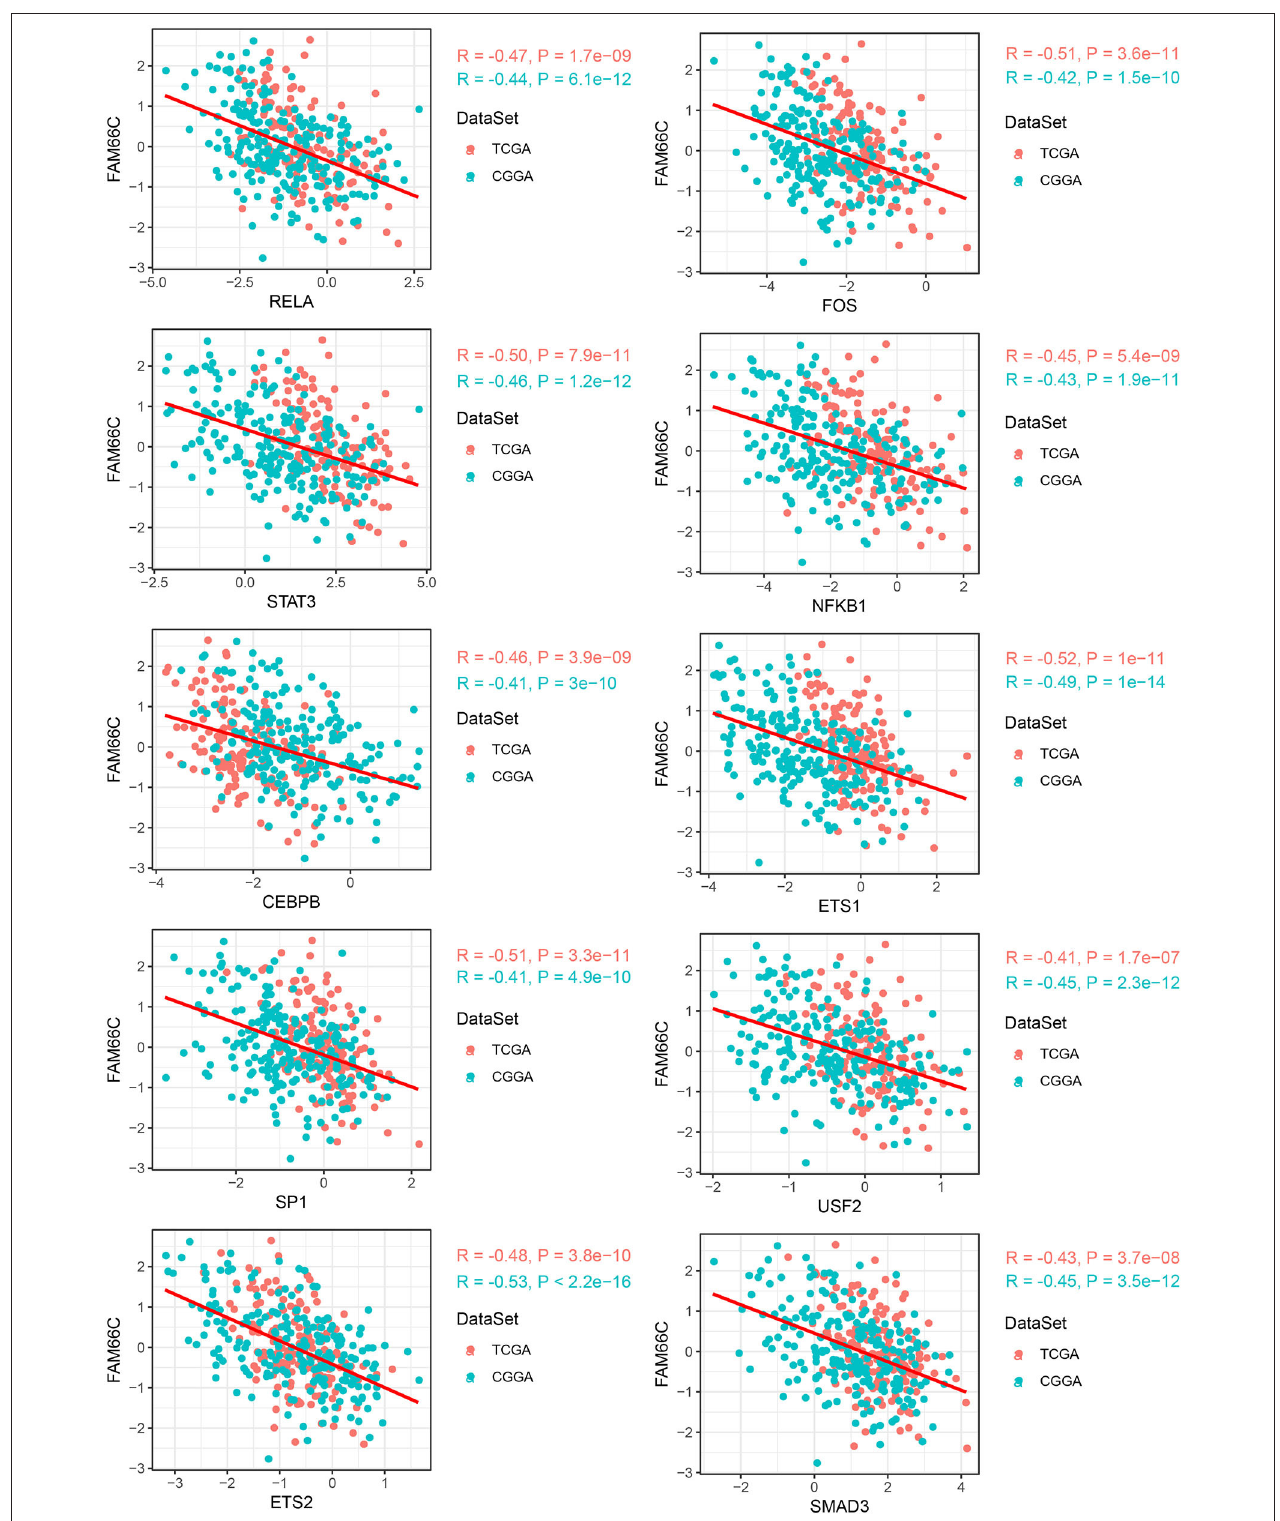
FIGURE 7 | LncRNA–TF pairs that exhibited negative correlation ( R < − 0.3) in both two datasets. Horizontal axis indicates TFs and vertical axis indicates lncRNAs. PCG, protein-coding gene; TF, transcription factor; RCI, relative concentration index.